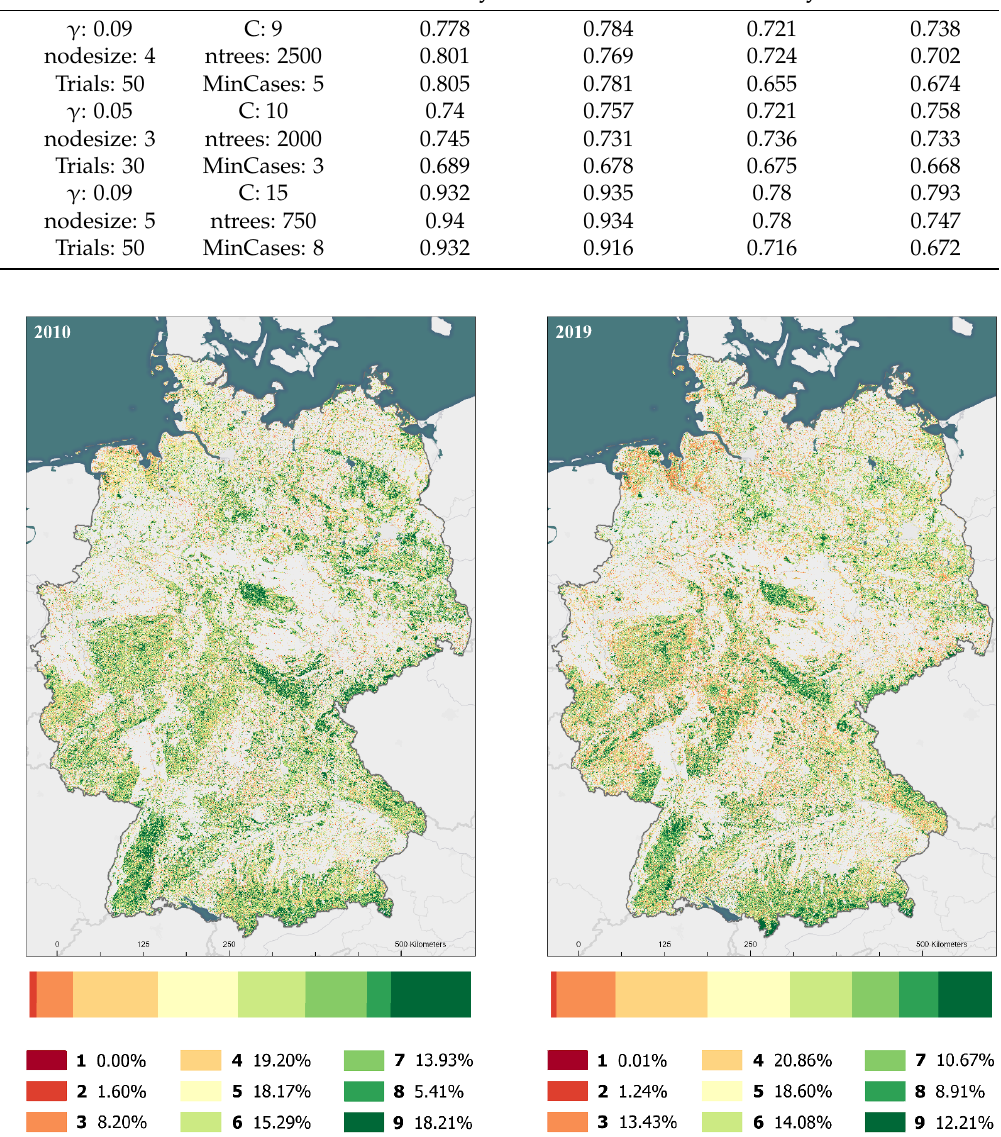
Figure 4. Heatmap of the number of models predicting the most frequent class per pixel. Colour bars show the proportions of pixels whose most frequent classification is made by the corresponding number of models. In both years, five or more models predict the same class for the majority of pixels, thus directly adopting the majority decision of the ensemble. The portion of pixels that are directly defined as non ‐ classifiable is <2% in both years (less than 3 models predicting the most frequent class).